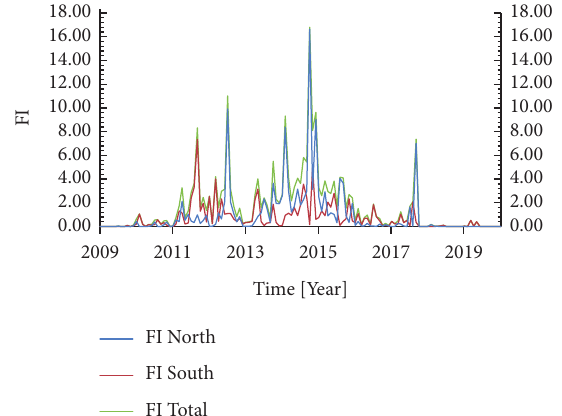
Figure 1: Temporal variation of the monthly FI data sets for the investigated time period. All data sets are smoothed by using the 12-step running average.